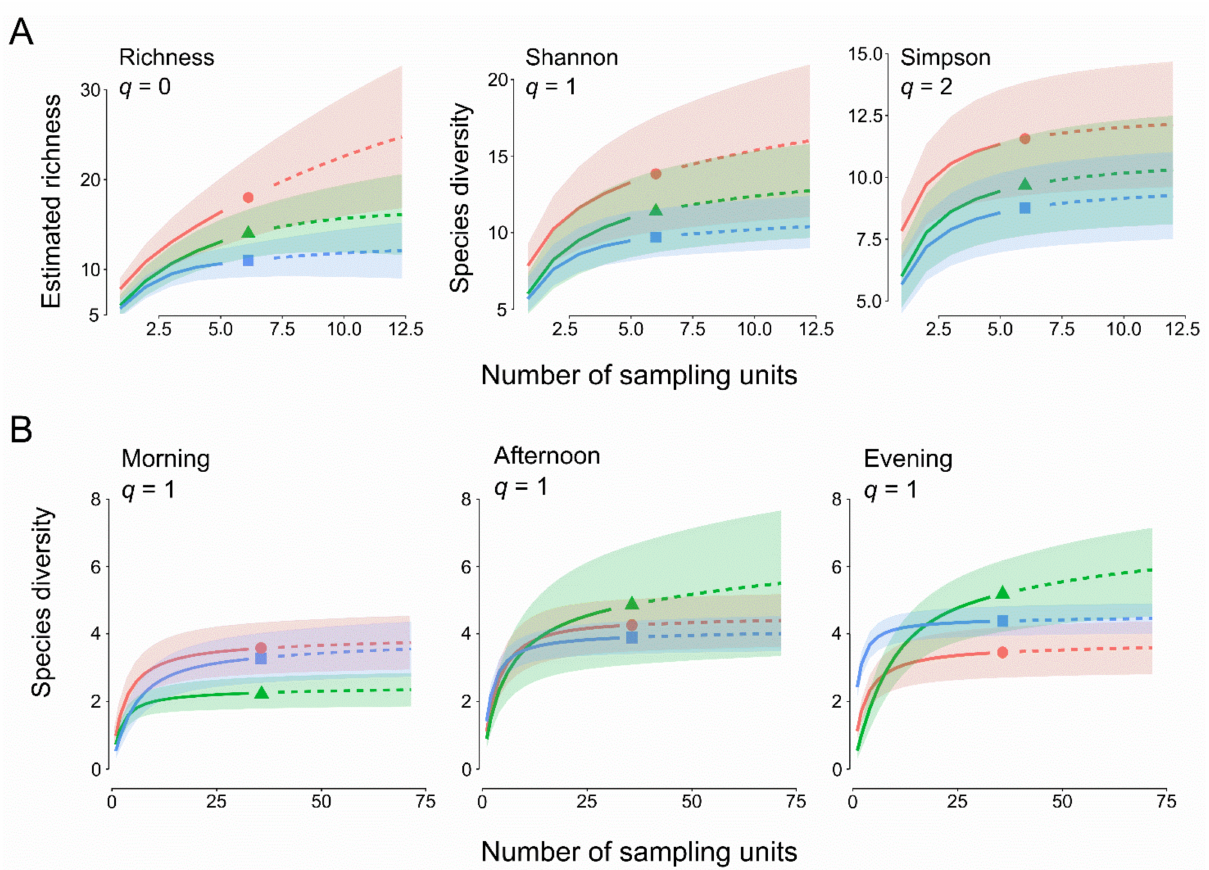
Figure 1. Sample-based plots for ant species diversity based on Hill numbers (q). ( A ) Pitfall trap sampling, ( B ) bait sampling, subdivided by daily period (morning, afternoon, and evening). For bait sampling, only q = 1 (Simpson index) is reported. Red circles, lines, and buffers: mature forest (MF); Green triangles, lines, and buffers: harvested forest (HF); blue squares, lines, and buffers: olive plantations